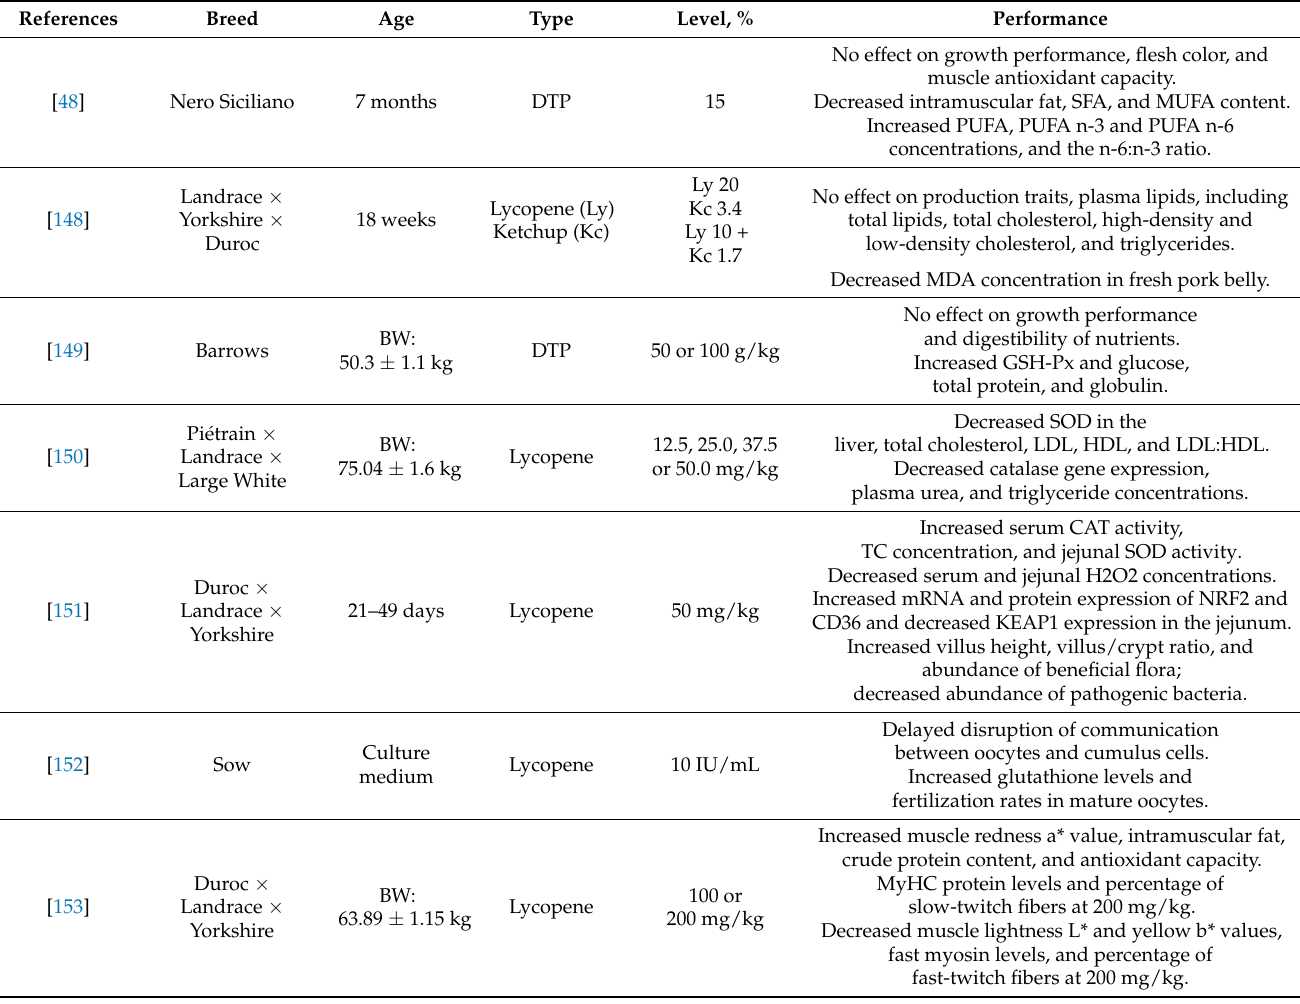
Table 7. The effect of tomato pomace on